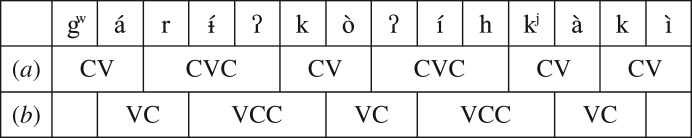
Alternative segmentations of Bora  ‘in order to toast’ into (a) syllables and (b) V-to-V intervals. Note that word-initial consonants are associated with preceding V-to-V intervals and word-final vowels with the following ones within phrases.